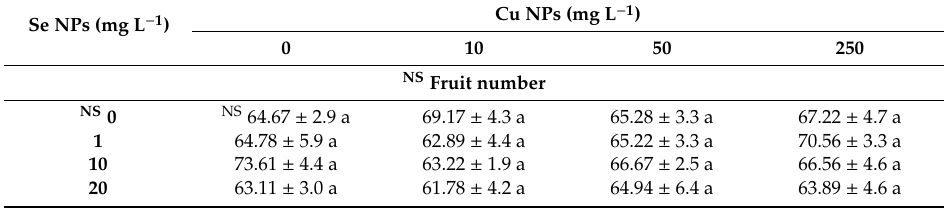
Table 1. Tomato crop yield with application of selenium (Se) and copper (Cu) nanoparticles